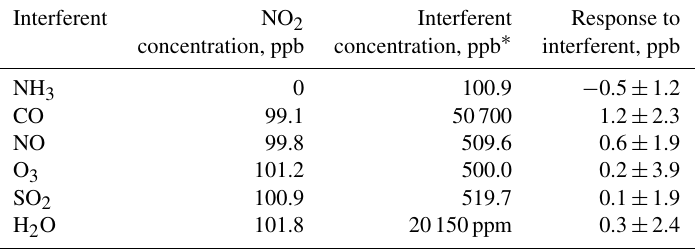
Table 2. Interference test results for FEM certification, 2B Technologies model 405nm NO 2 / NO / NO x folded tubular